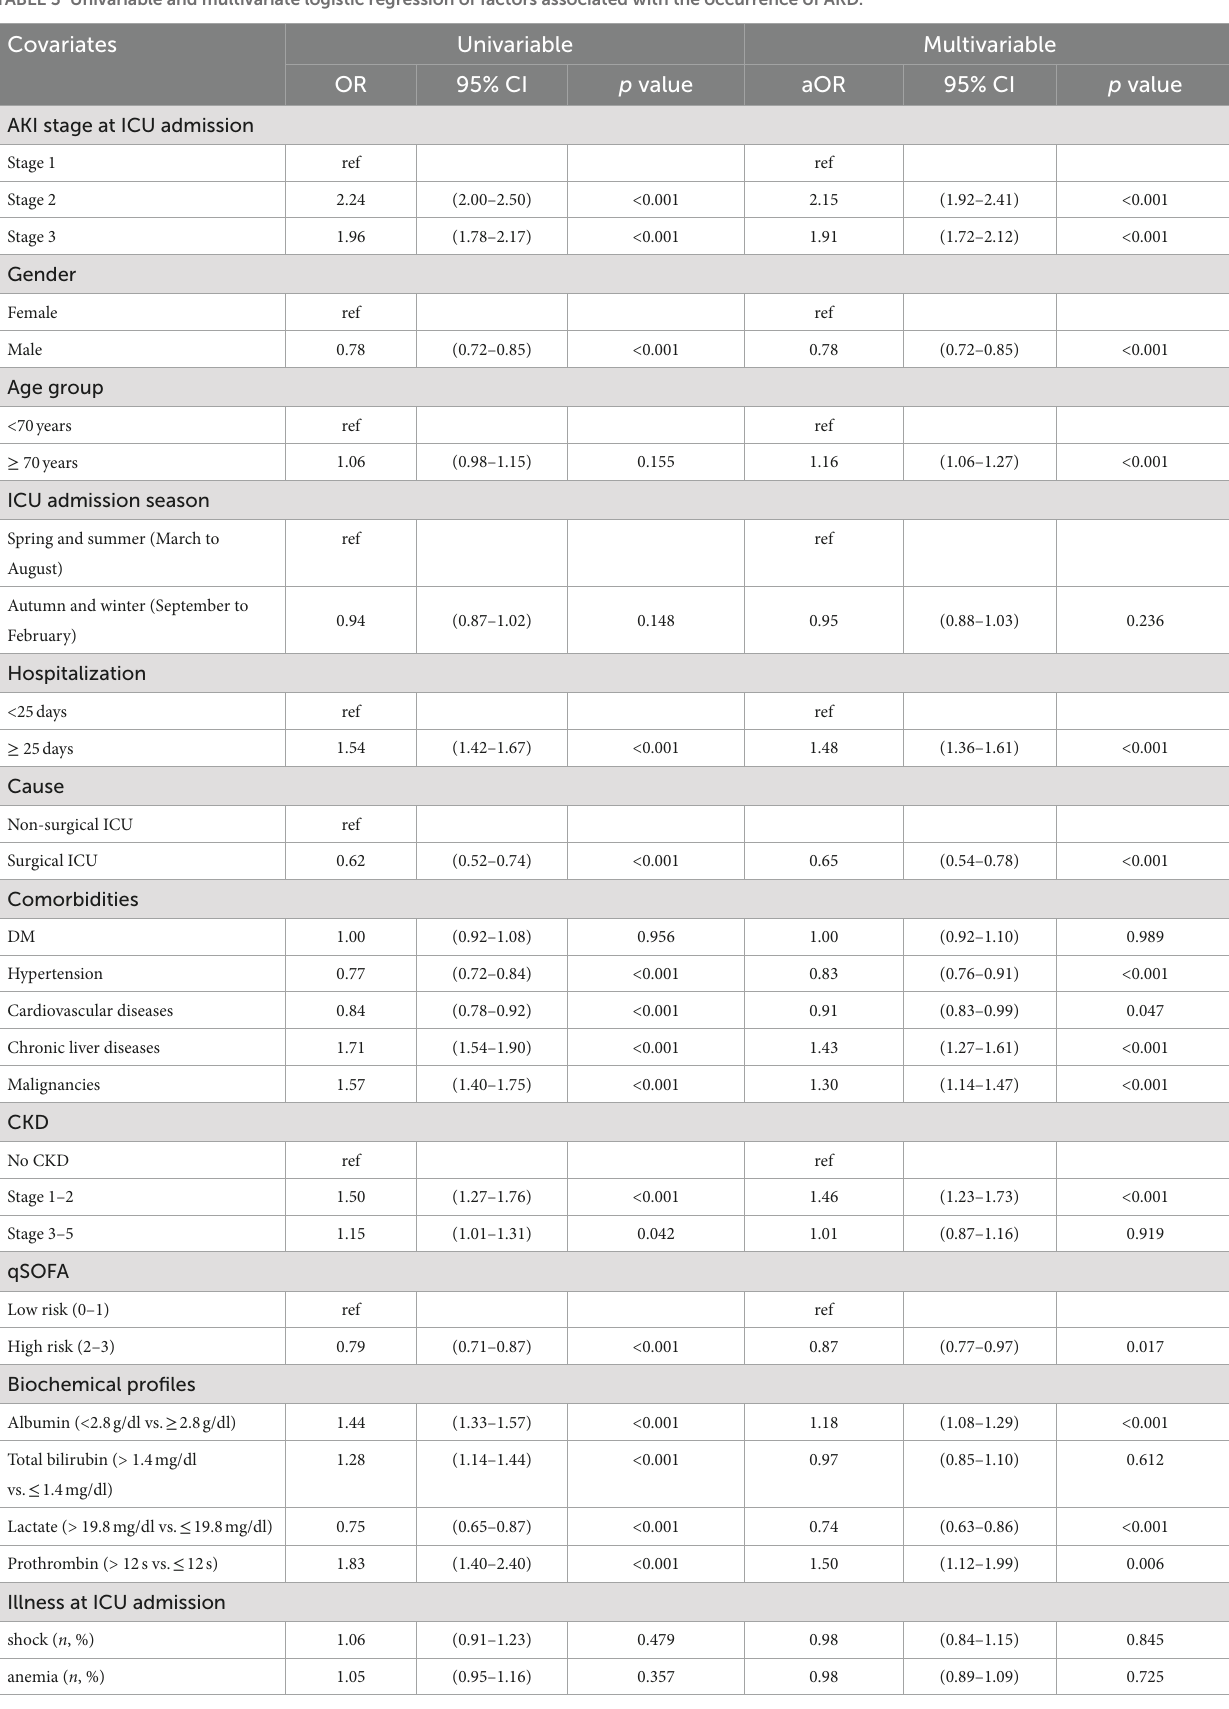
TABLE 3 Univariable and multivariate logistic regression of factors associated with the occurrence of AKD. Covariates Univariable